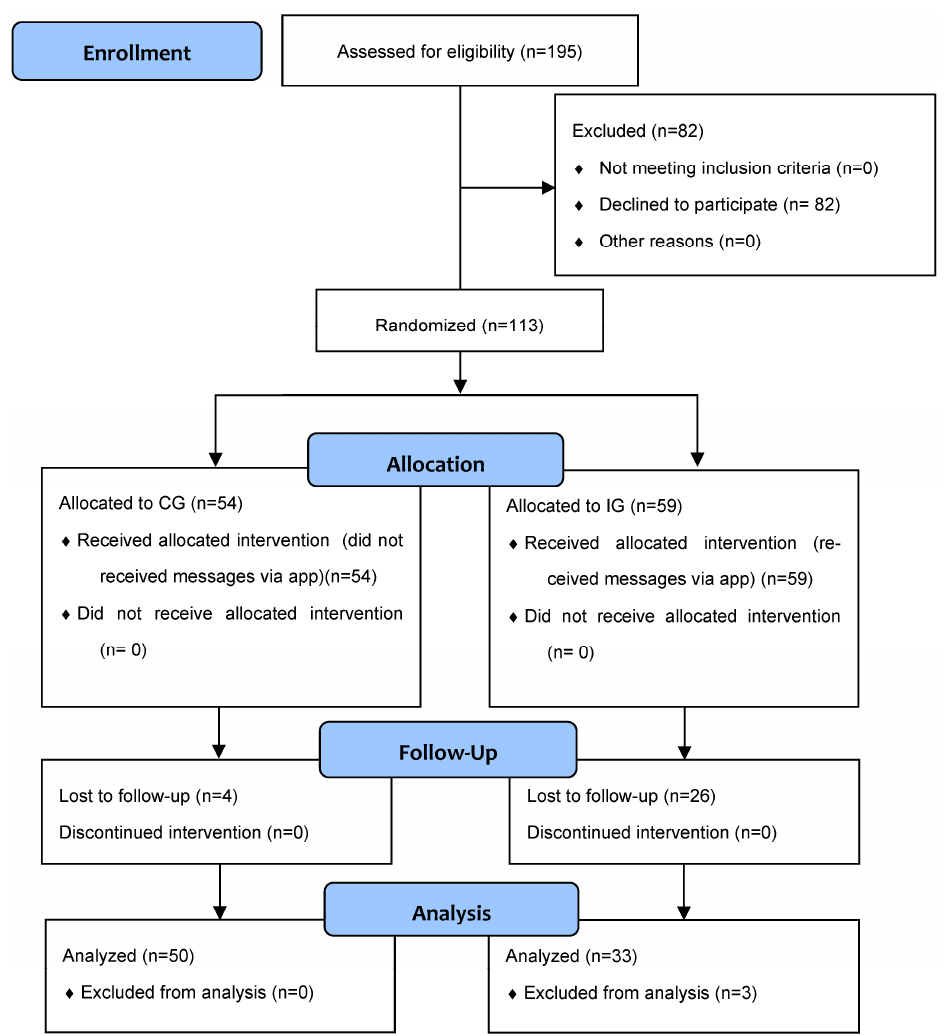
Figure 1. CONSORT (Consolidated Standards of Reporting Trials) 2010 Flow Diagram.